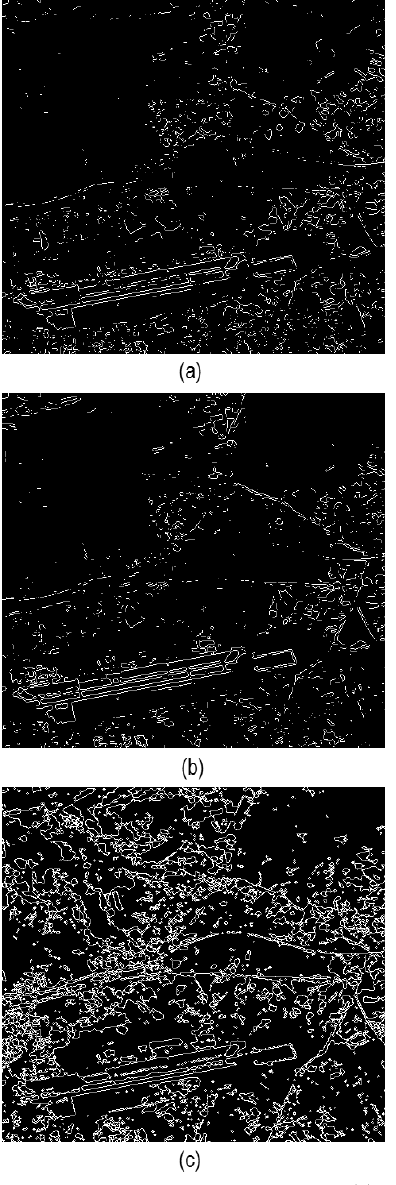
Figure 5: Edges of R-band of Rasat test image: (a) Sobel, (b) Prewitt, (c) Proposed Method.